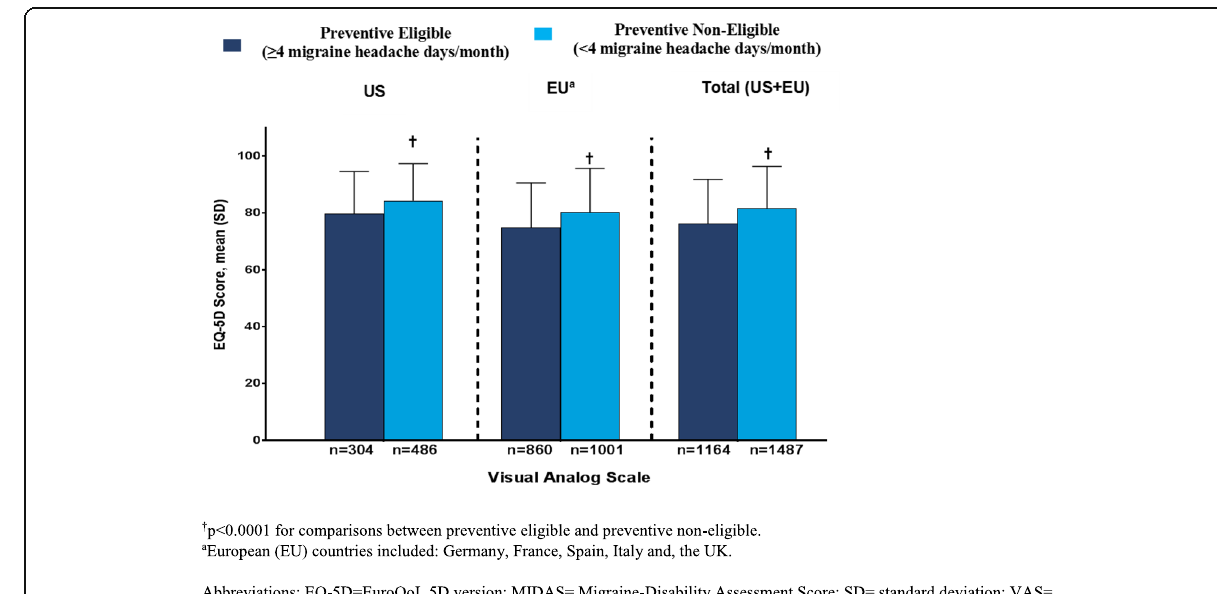
Fig. 3 EQ-5D VAS score in patients with migraine by preventive treatment eligibility status